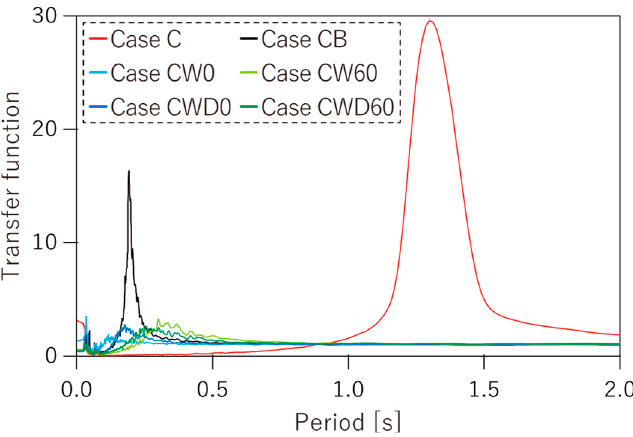
Figure 16. Amplitude of acceleration transfer function under white noise